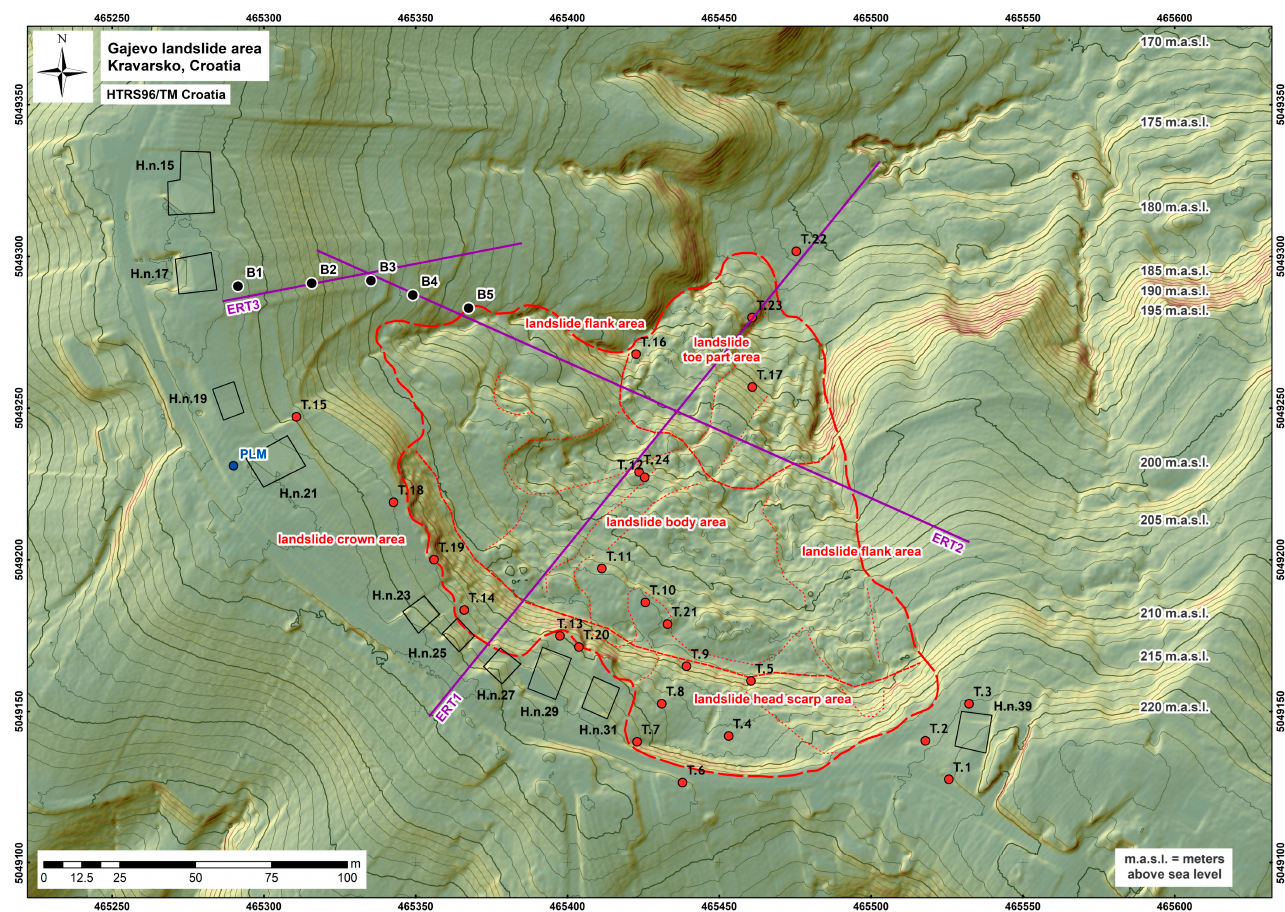
Figure 2. Gajevo landslide area overview with marked landslide features on high-resolution terrain slope model (0.5 × 0.5 m) with visible terrain morphology and locations of the ERT1–3 cross-sections (cross-section markings are placed at cross-sections starting points), boreholes (B1–5), installed pluviometer (PLM), field points (T1–24) used in mapping and houses “above” the landslide (house numbers 15–31 and 39). Multiple smaller landslides/deformations/cracks within the area of the initial landslide are also marked by thin red dashed